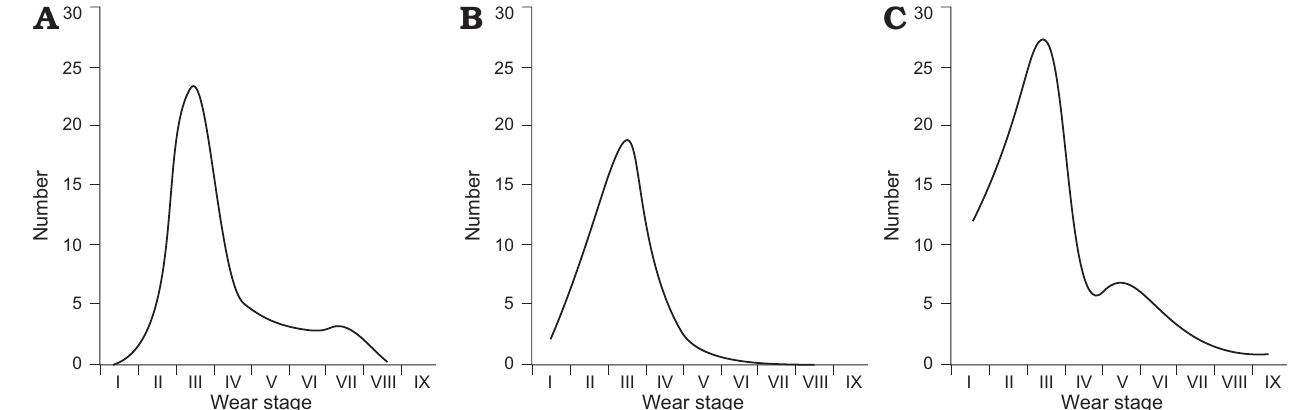
Fig. 2. Mortality profile of cave bears from Ur ş ilor (~45–40 calendar kyrs BP). A . Right M1 (N = 44). B . Right M2 (N = 36). C . Left mandible (N = 82).